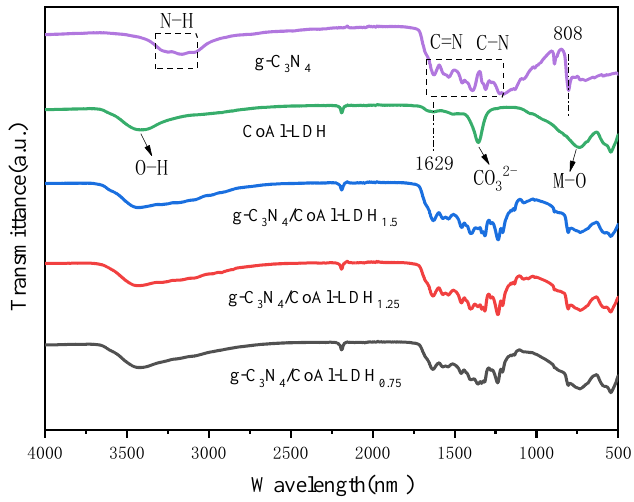
Figure 4. FT-IR spectra of the g-C 3 N 4 , CoAl-LDH, and the g-C 3 N 4 /CoAl-LDH nanocomposites.